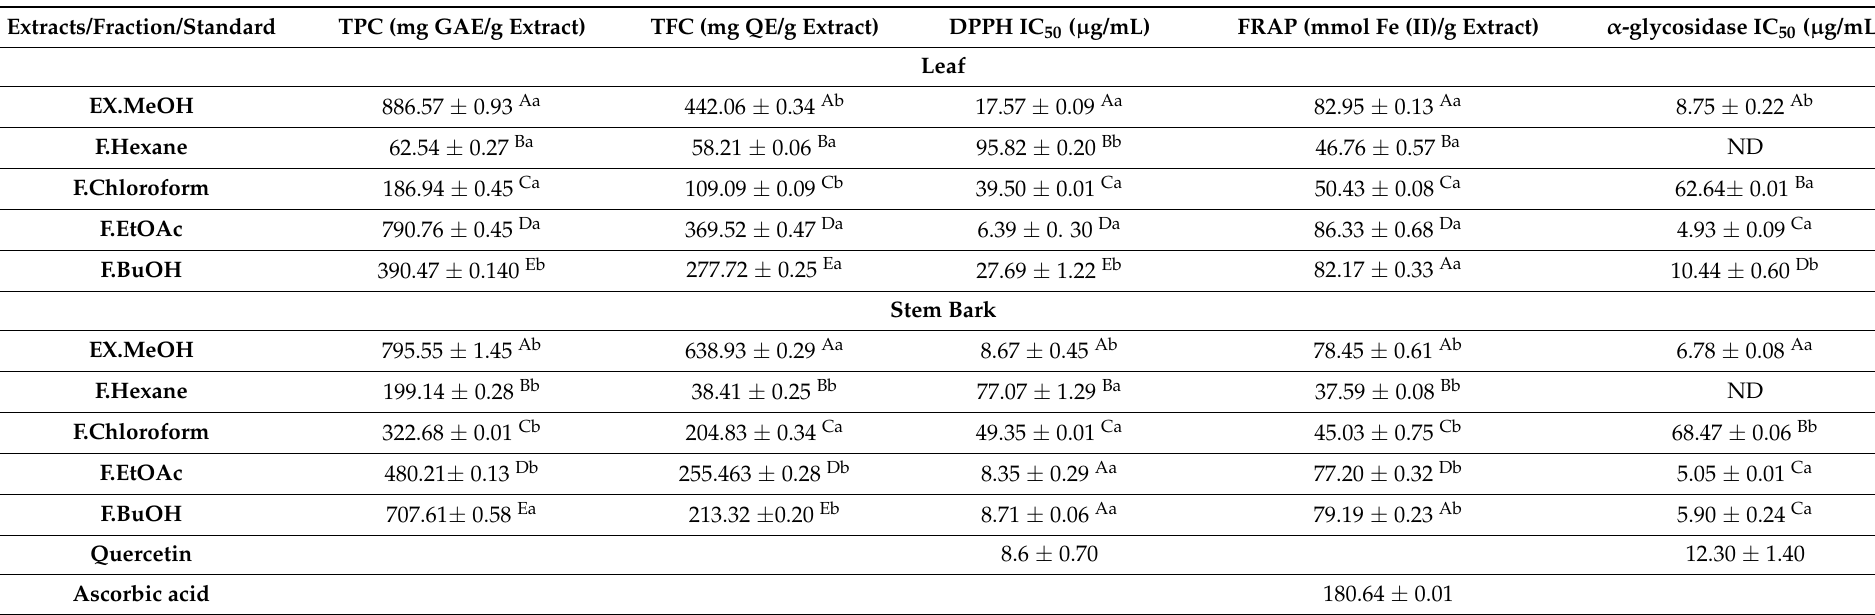
Table 1. TPC, TFC, DPPH, FRAP, and α -glucosidase inhibition, activity of extracts and fractions of A. pavarii